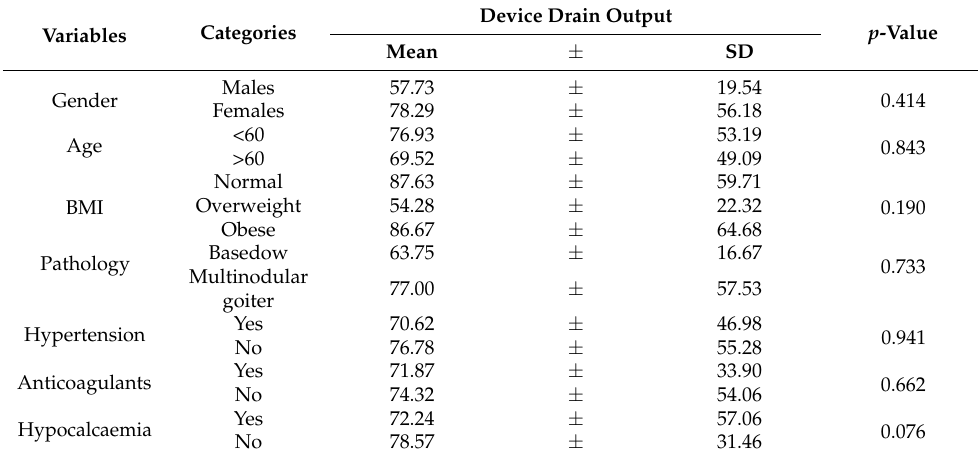
Table 5. Analysing variables influencing Drain output for Device group. Abbreviation: BMI: Body Mass Index.